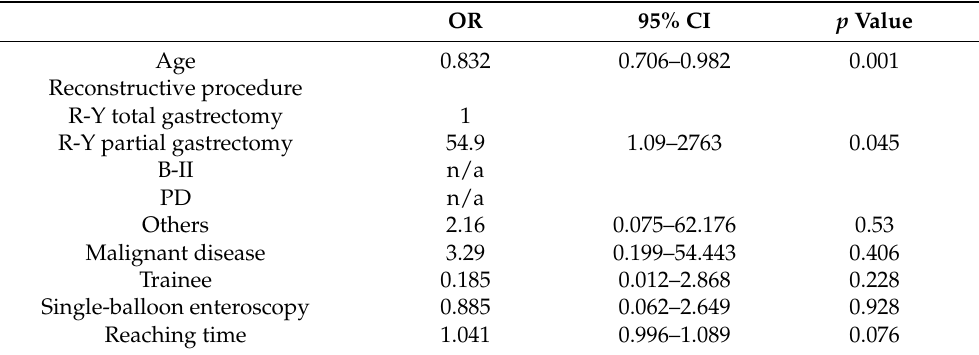
Table 4. Association between cannulation in ERCP and related clinic factors with a logistic regression model ( n = 84).